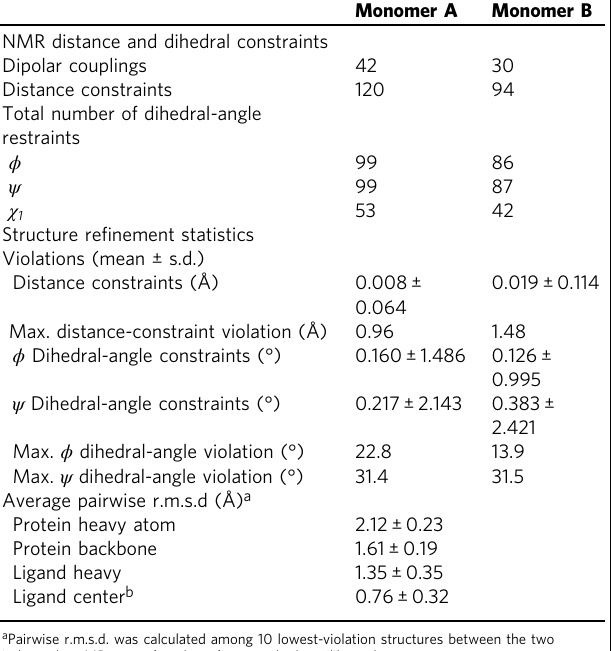
Table 1 Solid-state NMR and structure re fi nement statistics for F 4 -TPP + complexed S64V-EmrE structure in lipid